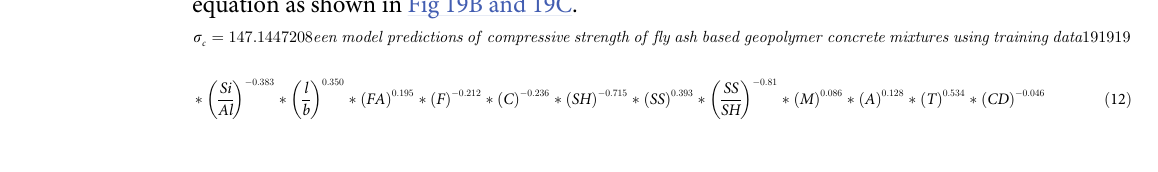
s ¼ 147 : 1447208 een model predictions of compressive strength of fly ash based geopolymer concrete mixtures using training data 191919 c